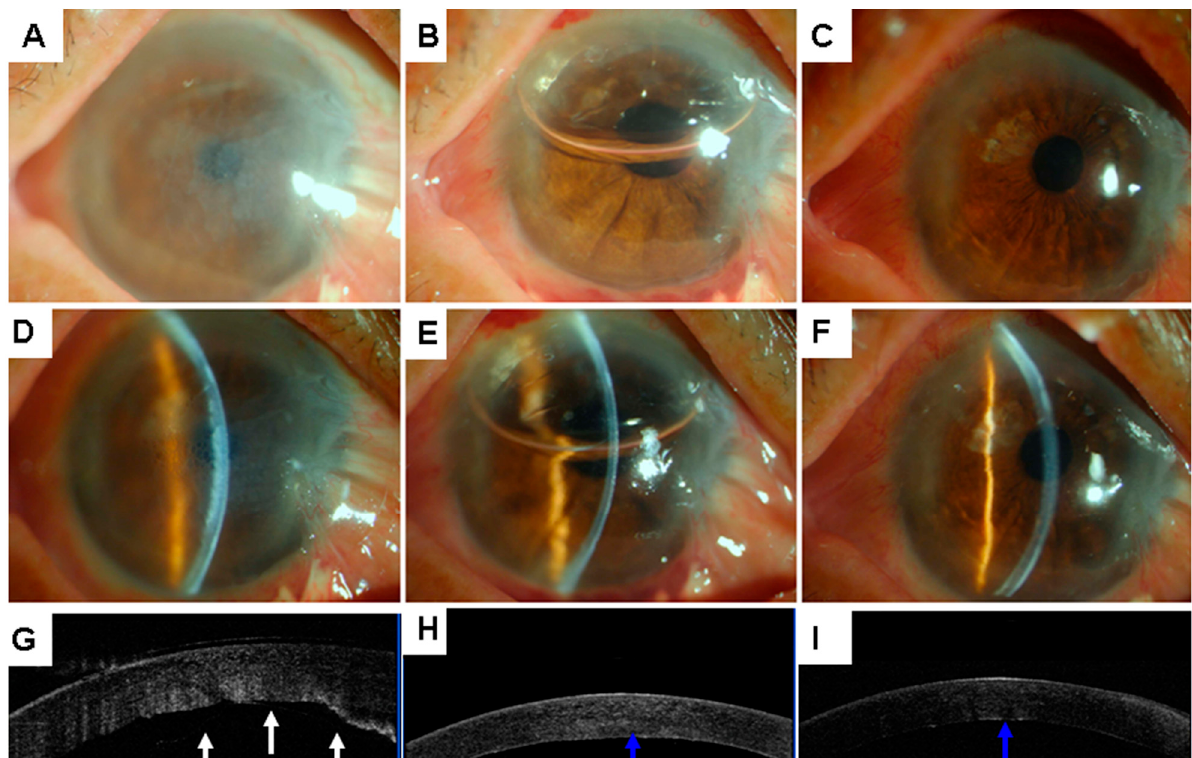
Figure 2. Slit-lamp photographs ( A – F ) and AS-OCT images ( G – I ) of case 1. Slit-lamp view of diffused corneal edema ( A , D ) and detached Descemet’s membrane ( G , white arrow) with stromal edema on day 5 after primary phacoemulsification. Slit-lamp view one day after air injection showing clear cornea ( B , E ) and reattachment of the Descemet’s membrane ( H , blue arrow). Slit-lamp view one month later showing clear cornea ( C , F ) and reattachment of Descemet’s membrane ( I , blue arrow). AS-OCT = anterior segment optical coherence tomography.